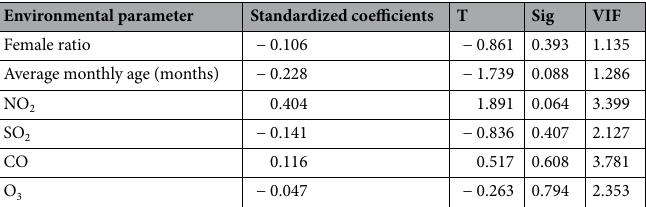
Table 5. Correlation between environmental factors and wheezing diseases in children. Dependent variable: number of wheezing diseases, t: t value, sig: significance. VIF: variance inflation factor.